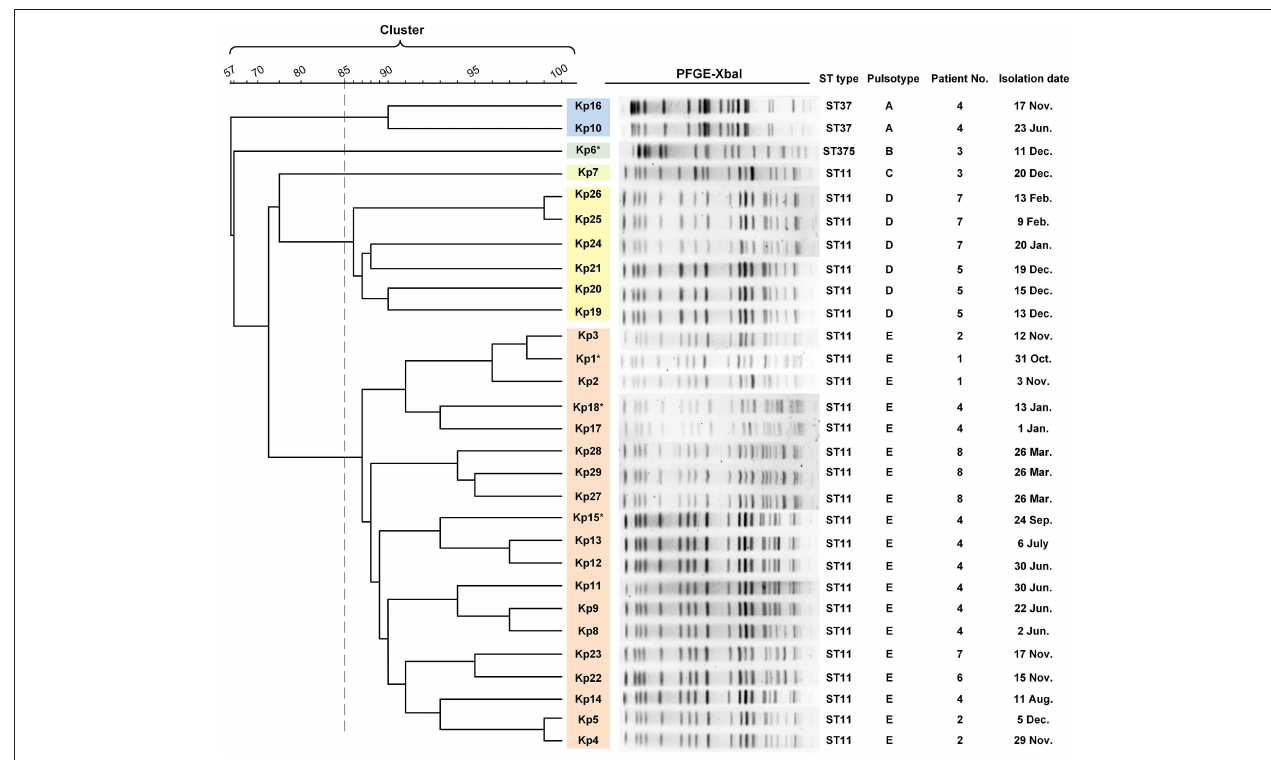
FIGURE 2 | PFGE results and MLST typing for 29 K. pneumoniae isolates. Genomic DNA from each of the 29 K. pneumoniae isolates was digested using XbaI and the digests subjected to pulsed-field gel electrophoresis to generate diagnostic genomic DNA fragmentation fingerprints. The dendrogram of the PFGE profiles is clustered by the UPGAMA on the basis of the Dice similarity by the Quantity One software package 4.6. The sequences of seven housekeeping genes ( gapA , infB , mdh , pgi , phoE , rpoB, and tonB ) were analyzed for the purpose of MLST typing. PFGE results showed that 29 isolates were divided into five different PFGE clusters (A–E) as represented by different colors. Cluster D and E accounted for 20.6% (6/27) and 65.5% (19/27) of ST11 isolates, respectively, indicating that those strains were highly homologous. The two ST37 isolates belonged to the same cluster (cluster A). Kp6 (ST375) and Kp7 (ST11) formed separate monotypic clusters, cluster B and C, respectively. Asterisk indicates the string test of isolate was